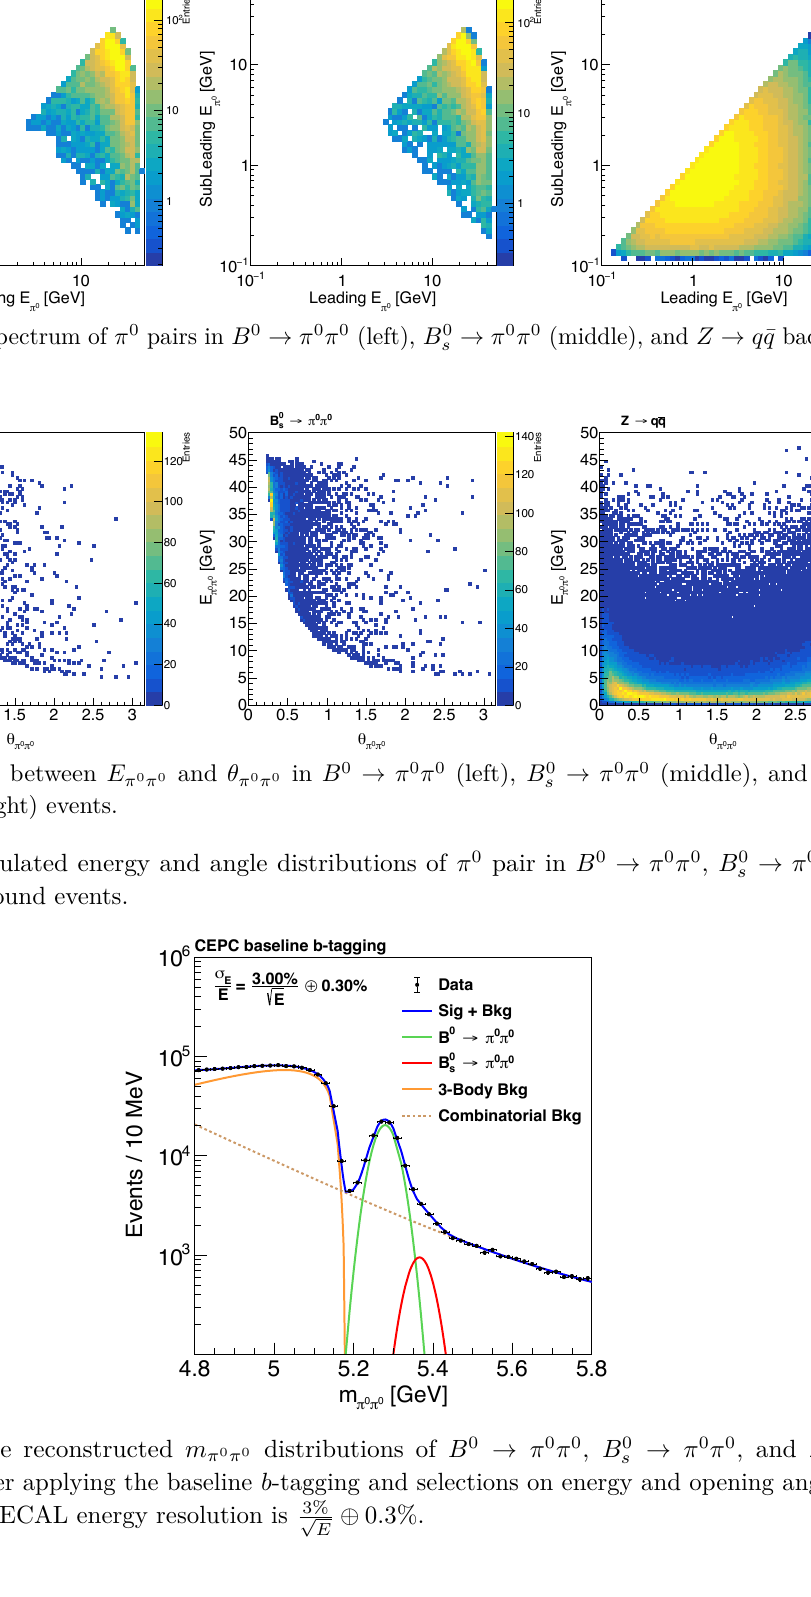
Figure 6 . The reconstructed m background after applying the baseline b -tagging and selections on energy and opening angle of π 0 pairs when the ECAL energy resolution is 3% √